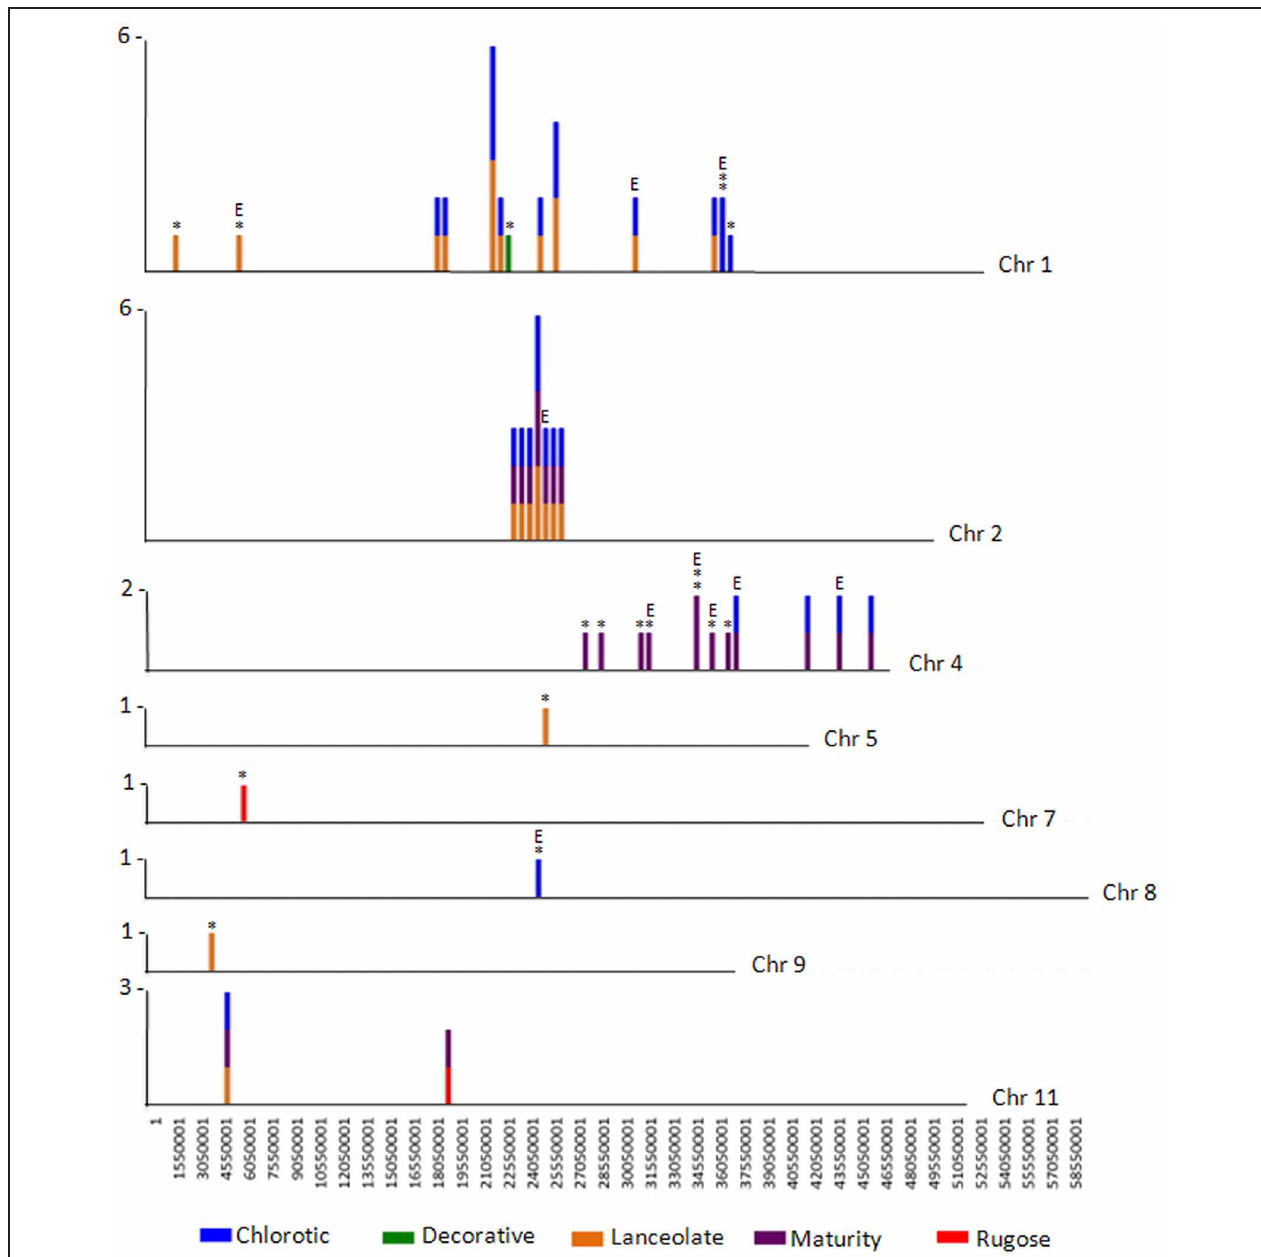
deletion is represented by color: blue, chlorotic; purple, maturity; green, decorative; red, rugose; orange, lanceolate. Deletions belonging to Class 3 are likely a result of FN mutagenesis and are highlighted by an asterisk ( ∗ ). Deletions potentially impacting gene expression are highlighted with an E. Note the region of natural variation (SV Class 2) shared by three mutant plants on chromosome